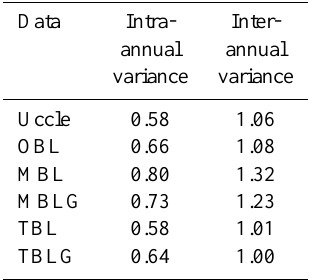
Table 4. Intra- and inter-annual variance of EDI for Uccle and BL models.